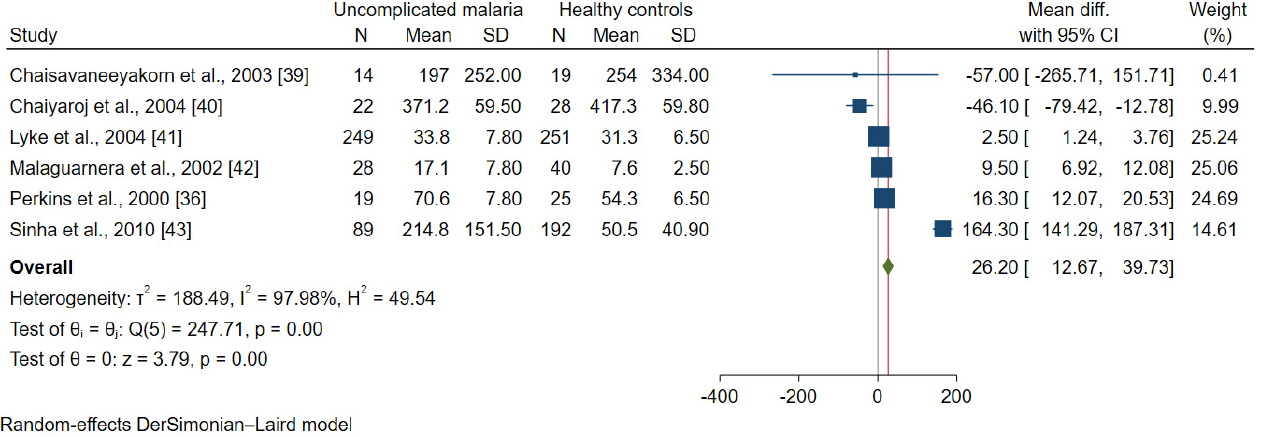
Figure 5. Forrest plot demonstrated the difference in the mean IL-12 levels (pg/mL) between patients with uncomplicated malaria and healthy controls [36,39–43]. Abbreviation: Mean Diff., mean difference; CI, confidence interval. Explanation of the forest plot: squared-box symbol, point estimate; green diamond and red line: pooled mean difference: blue line: line of no effect; I 2 , level of heterogeneity; p = 0.00 or less than 0.05, significant heterogeneity.